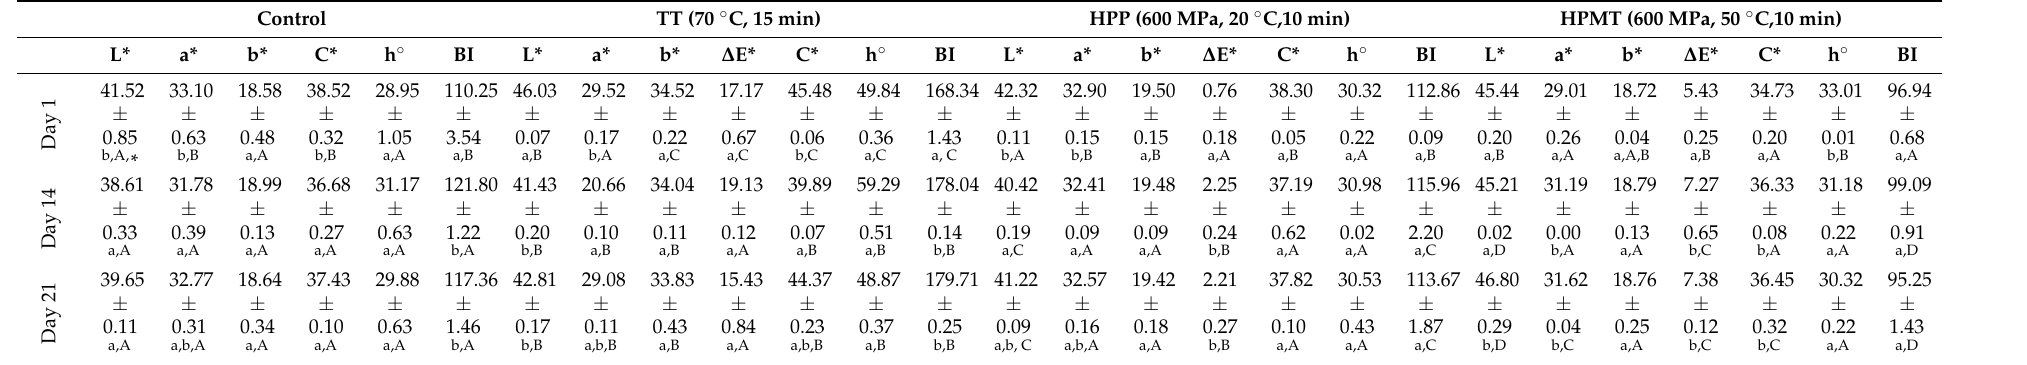
Table 4. Color changes in samples compared to control during 21 days of refrigerated